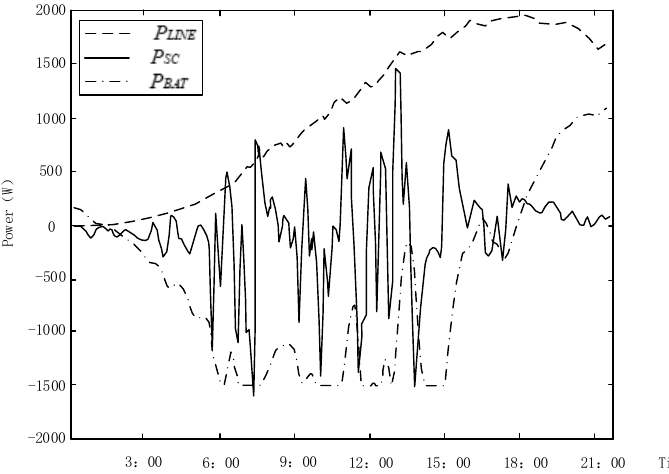
Energies 2018 , 11 , x FOR PEER REVIEW Figure 4. Microgrid operation during the traditional hybrid energy storage capacity of the configuration.